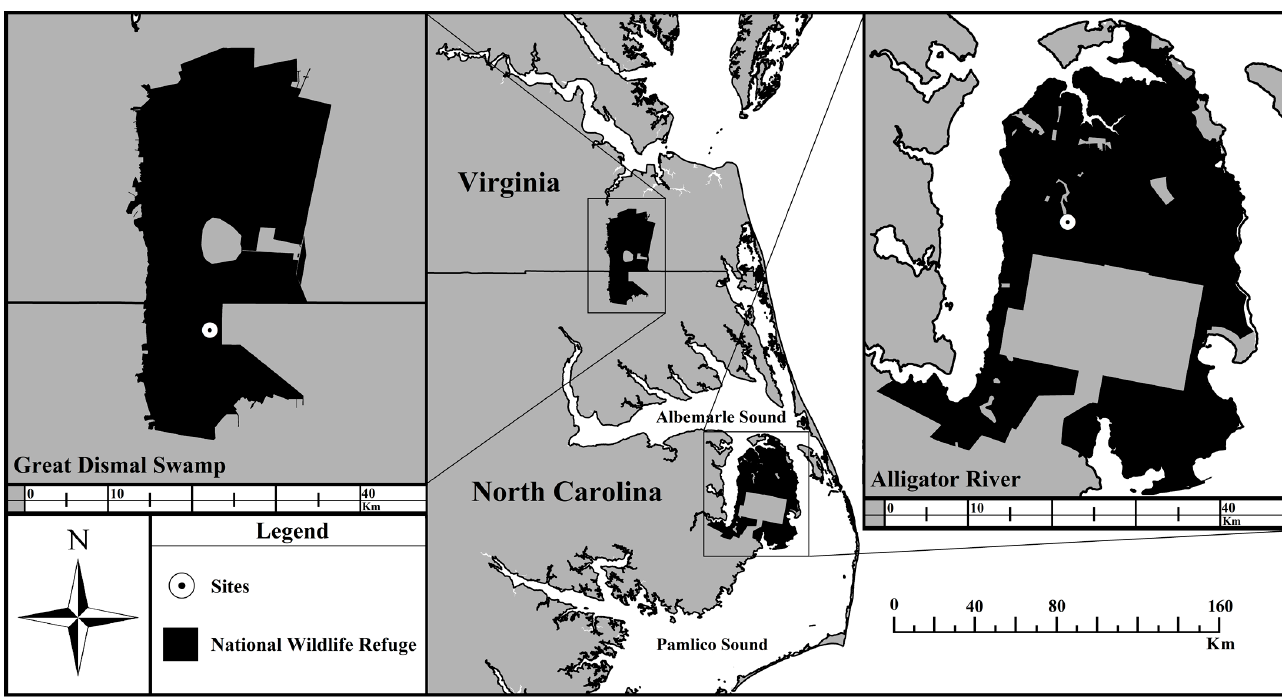
Figure 1. Location of Great Dismal Swamp National Wildlife Refuge (GDSNWR) and Alligator River National Wildlife Refuge (ARNWR). Alligator River forms the western boundary of the Albemarle-Pamlico Peninsula.